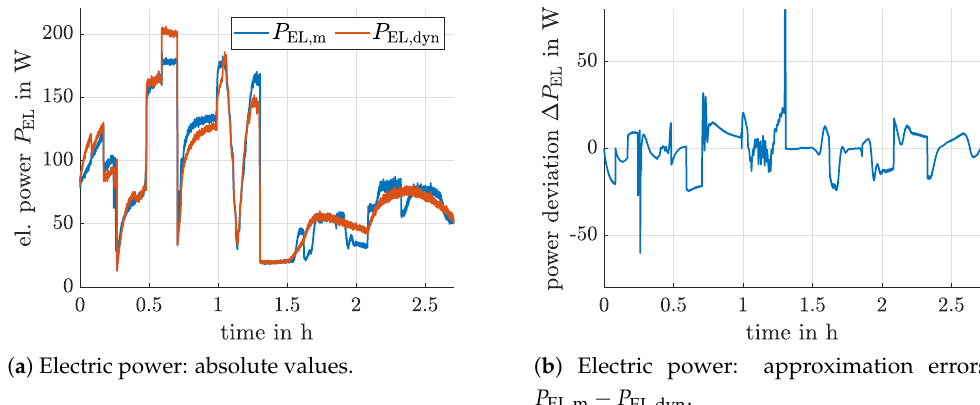
Figure 6. Comparison between measured and estimated stack power, P EL,m and P EL,dyn , for the system model in Figure 5.